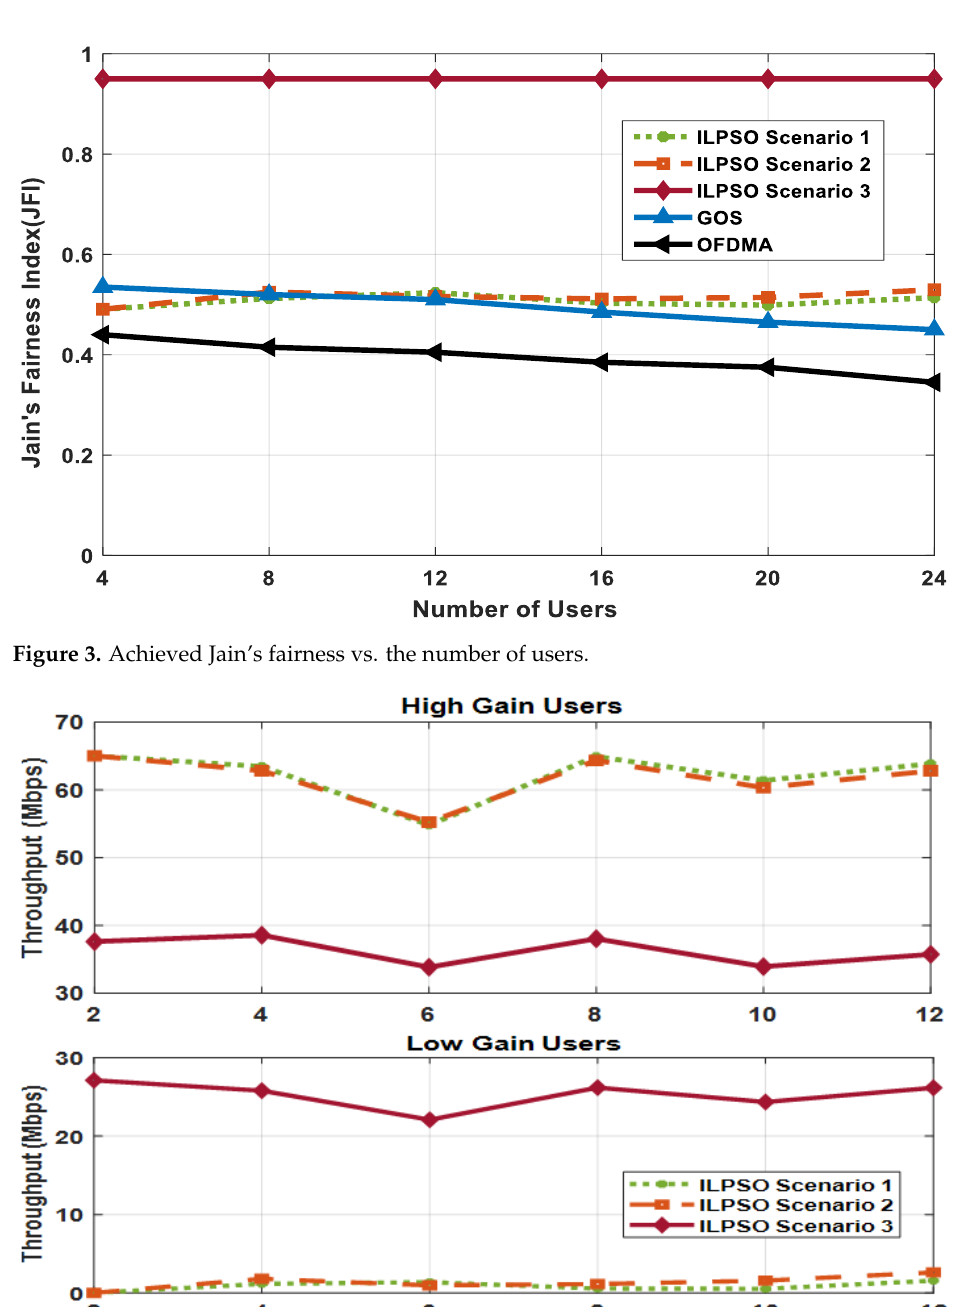
Figure 5. Algorithm convergence vs. achieved throughput.